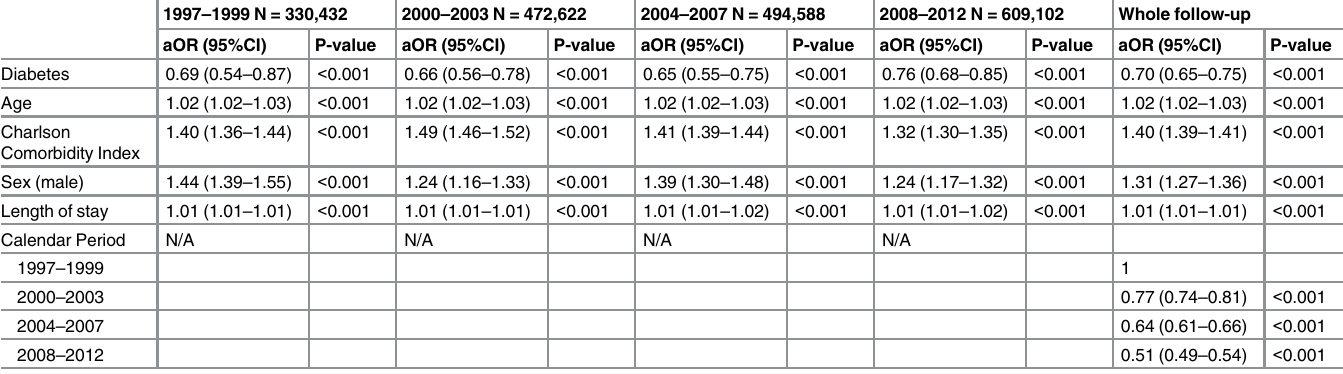
Table 3. Multivariable analysis of the factors associated with mortality among HIV-infected patients in Spain, 1997 –